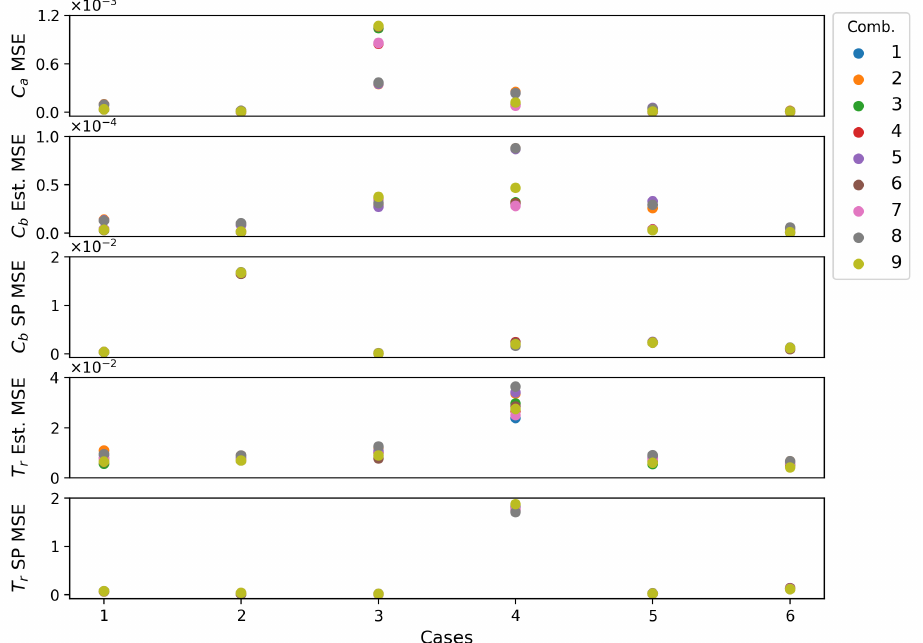
Figure 8. Mean squared error values calculated for estimations of C A , C B and T r , and the set-points of C B and T r for the studied cases and the nine combinations.